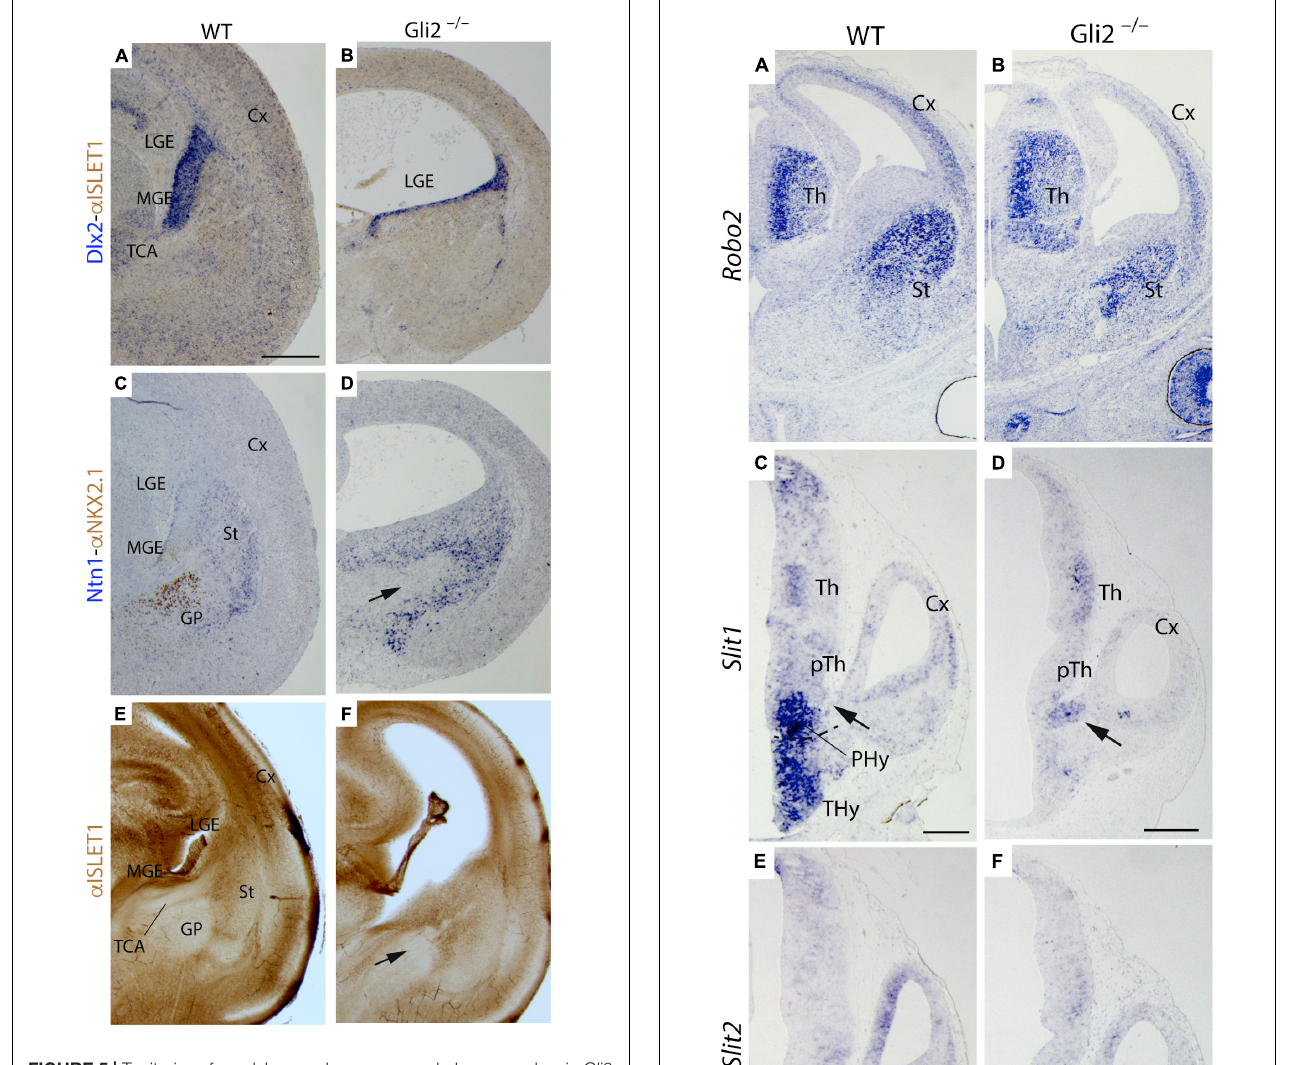
FIGURE 5 | Territories of caudal secondary prosencephalon secondary in Gli2 mutant mice. Frontal paraffin (7 µ m) (A–D) and vibratome (100 µ m) sections (E,F) through wild type and Gli2 − / − of E18.5 embryos with Dlx2 in situ hybridization combined with α -Islet 1 immunoreacted in brown (A,B) ; Ntn1 in situ hybridization combined with α -NKX2.1 immunoreacted in brown (C,D) ; and α - ISLET1 immunohistochemistry (E,F) . In wild type, the ganglionic eminences are differentiated structures (LGE and MGE) but in the mutant, the Dlx2 expression is reduced and seems to correspond to the LGE (A,B) . In the wild type, α -NKX2.1 labels the globus pallidus and ventricular MGE, meanwhile Netrin1 is expressed in the striatum [LGE mantle layer; (C) ]. In the mutant, α -NKX2.1 is not detected and there is a wider Netrin1 positive territory [arrow in (D) ]. In wild type, α -ISLET1 labels the striatum (E) but in Gli2 − / − , these labeling is also expanded [arrow in (F) ]. Note that the lateral ventricles appeared expanded in the mutant. Cx, Cortex; GE, ganglionic eminences; GP, globus pallidus; LGE, lateral ganglionic eminence; MGE, medial ganglionic eminence; St, striatum; TCA, thalamocortical axon. Scale bar: (A,C,E) 200 µ m; (B,D,F) 300 µ m. their direction. In axon pathfinding, therefore, not only guidance factors are crucial but their precise distribution in time and space constitutes an essential part of the process.